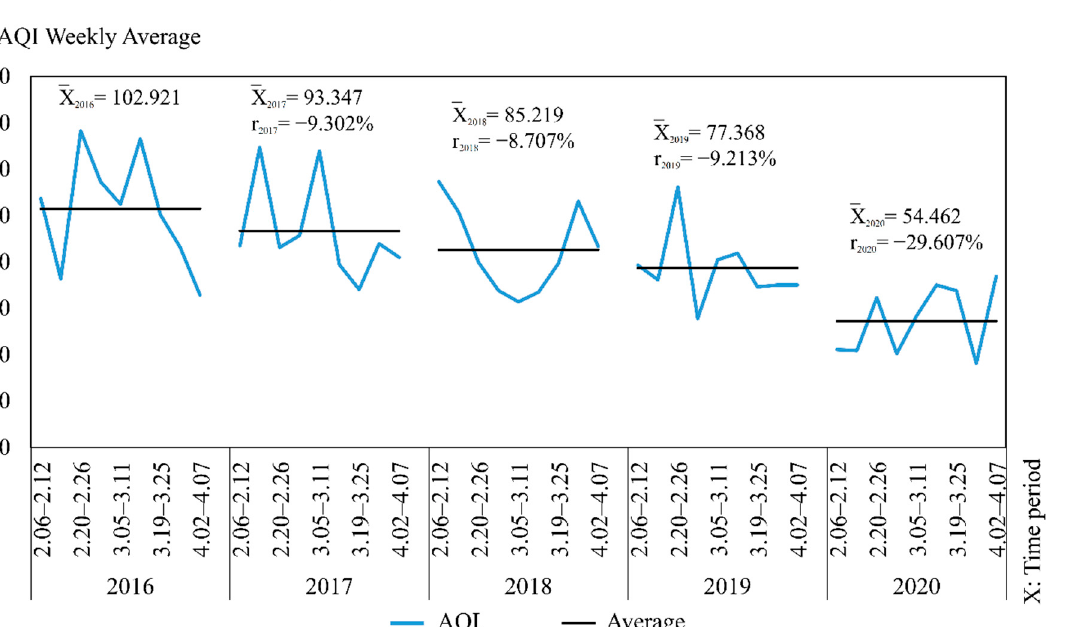
Table 2. Overall air quality excellent rate statistics from 2016 to 2020.